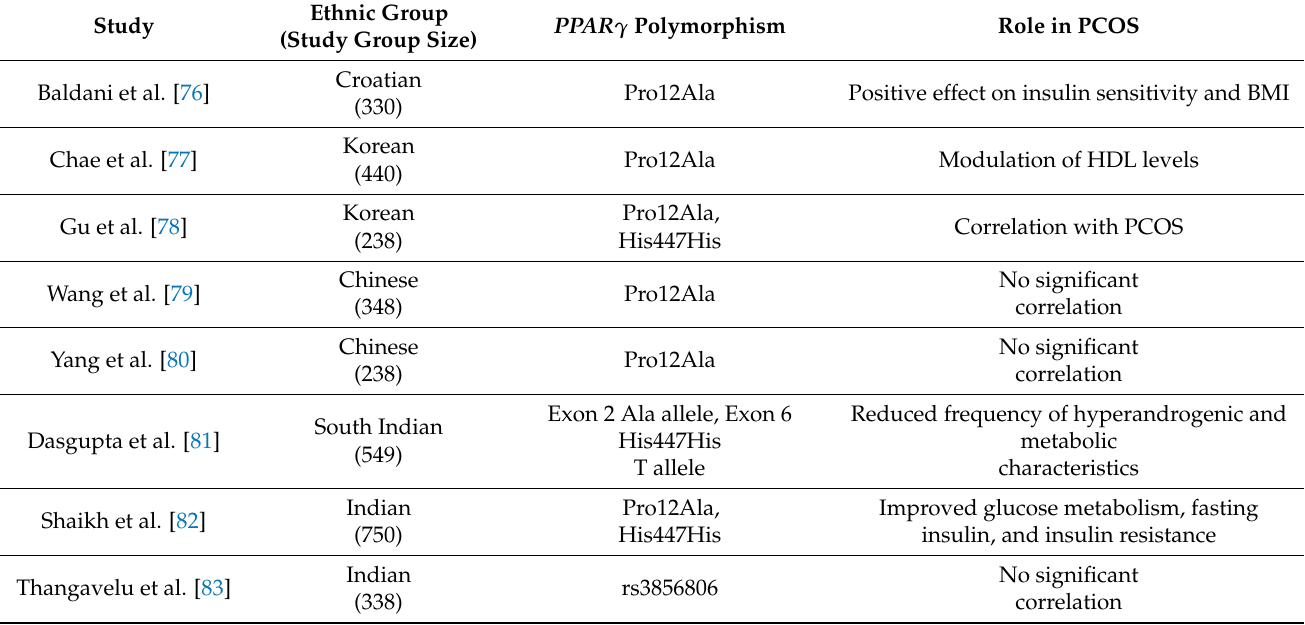
Table 1. The role of PPAR γ polymorphisms in PCOS, with a special focus on patients’